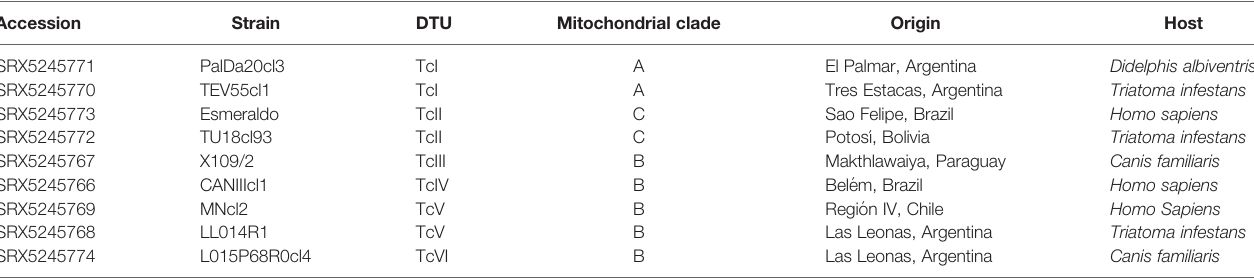
TABLE 1 | Datasets used in this